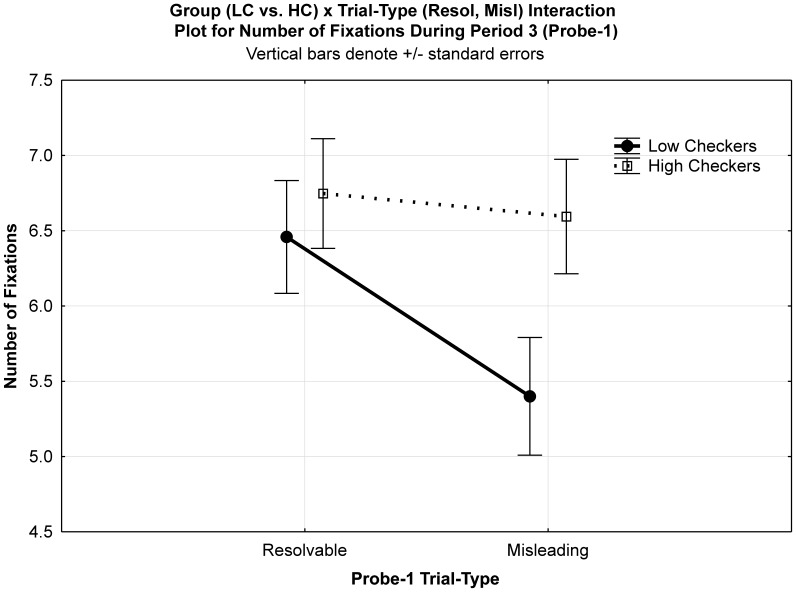
Fixation numbers for Period 3.Graph shows the Group×Trial-Type interaction.